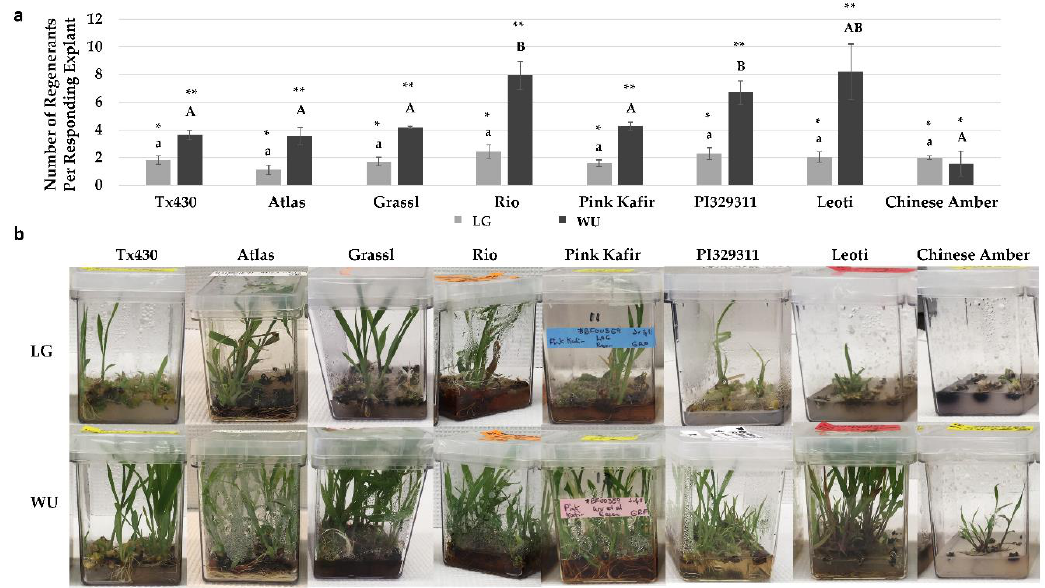
Figure 5. Impact of LG and WU protocols on the regeneration response for the various genotypes. ( a ) Mean number of regenerants per responding explant following eight weeks in culture. Results are plotted as the mean of three independent experiments ( ± SE). ( b ) Representative images of cultures in Magenta boxes (12 explants per box) for each genotype and protocol combination, illustrating the levels of plantlet regeneration. Data shown in ( a ) were analyzed by one-way ANOVA, and tested for significance using Tukey’s HSD Post-hoc Test. For comparisons across genotypes for the LG protocol, those with the same lowercase letter are not significantly di ff erent at p ≤ 0.05. For comparisons across genotypes for the WU protocol, those with the same uppercase letter are not significantly di ff erent at p ≤ 0.05. For comparisons across the two media within a genotype, those with the same asterisk pattern are not significantly different at p ≤ 0.05.